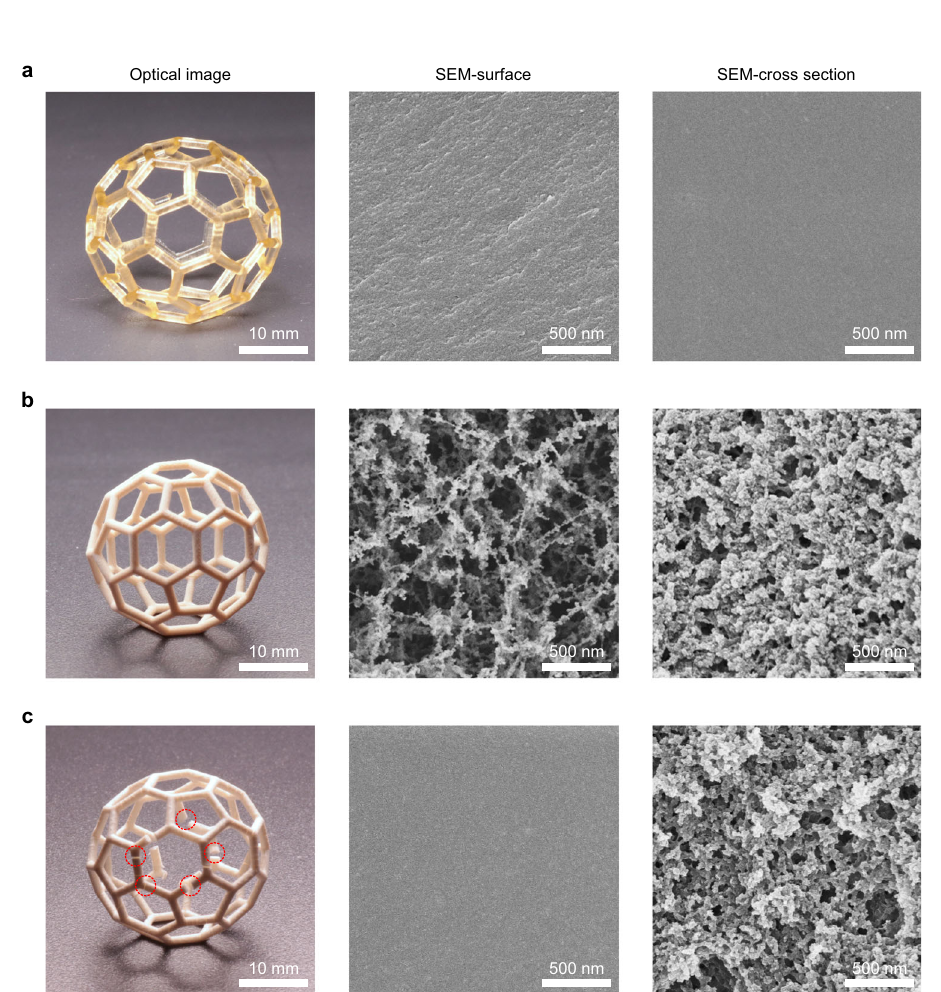
Fig. 2 Supercritical drying for preserving the structural integrity and complete porosity of the inherently nanoporous 3D objects. Photographs and SEM micrographs of ( a ) a non-porous 3D object printed using an ink without porogens (60 wt% HEMA, 40 wt% EDMA, 4 wt% Irgacure 819 with respect to monomers) followed by supercritical drying, ( b ) an inherently nanoporous 3D object printed using an ink with porogens (30 wt% HEMA, 20 wt% EDMA, 40 wt% cyclohexanol, 10 wt% 1-decanol, 4 wt% Irgacure 819 with respect to monomers) followed by supercritical drying, and ( c ) a 3D object printed using the ink with porogens followed by air drying, with cracks visible on the photograph. The surface and cross-sectional SEM images shown are representative of three replicates ( n = 3) over three independent experiments ( N =